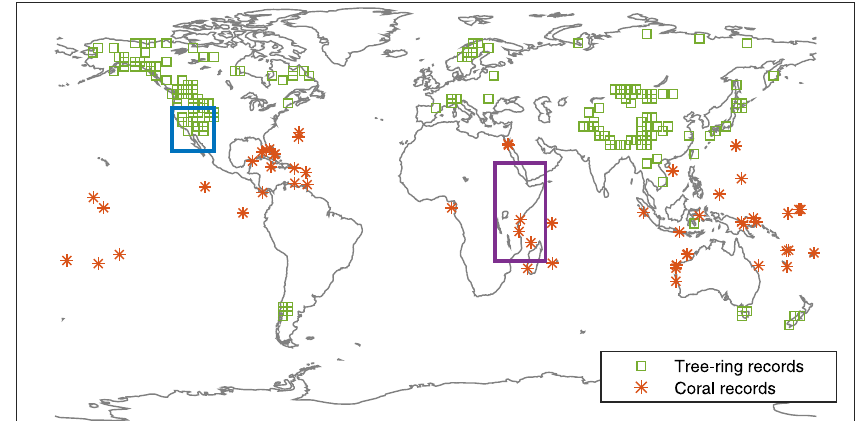
Figure 1. Pseudoproxy network used in this study based on the PAGES2k global database of tree-ring and coral records (PAGES2k Con- sortium, 2017), and the drought regions explored in this study, with the North American Southwest in blue and equatorial East Africa in